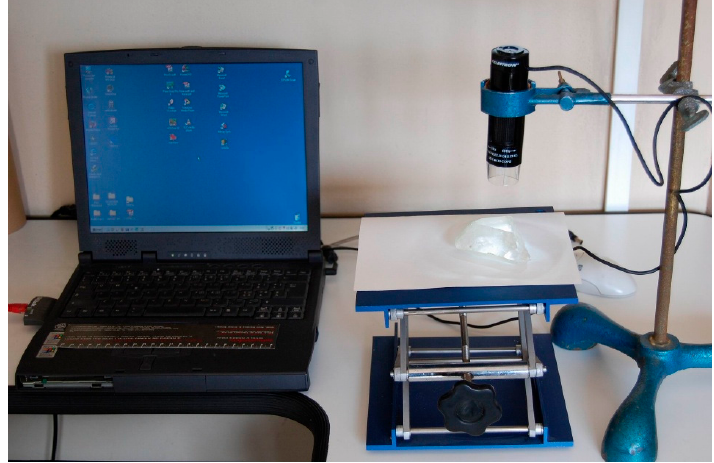
Figure 3. The simple device used to obtain a zenithal image of drops on horizontal surfaces. The handled microscope is suspended and stopped in a laboratory stand, at fixed height and fixed focus distance, previously checked. The lab screw jack is used as vertical translator stage and hosts in this picture a calcite crystal. A simple portable PC is enough to acquire the images via a USB connection.